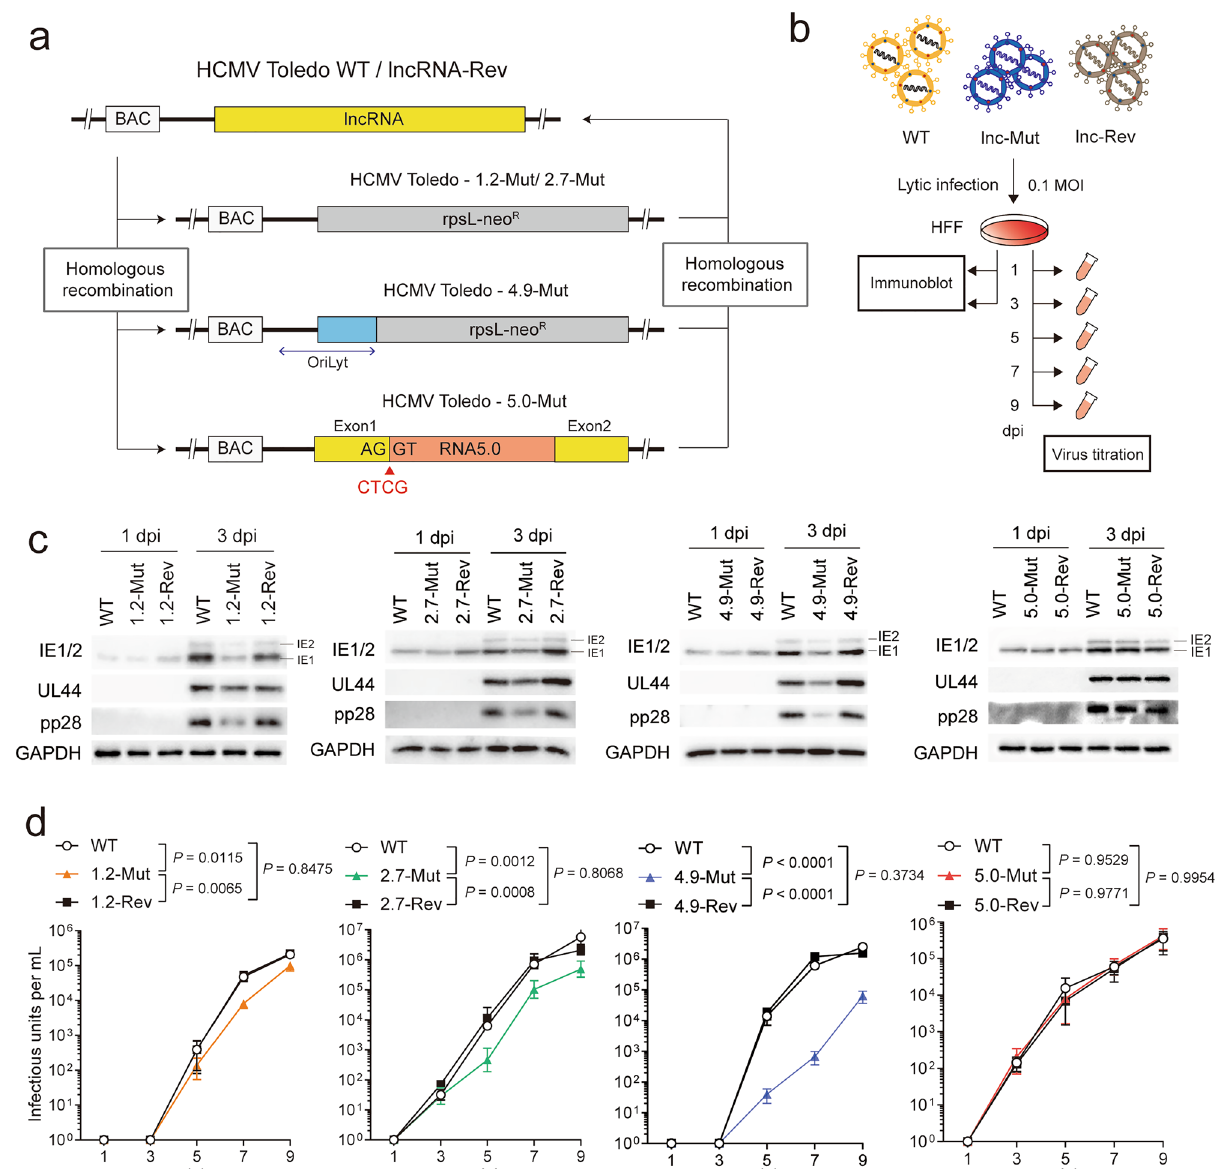
Figure 2. HCMV lncRNAs other than RNA5.0 are required for lytic replication in HFFs. ( a ) Schematic representation for generation of HCMV lncRNA-Mut virus. ( b ) Schematic representation of lytic infection analysis in HFFs using WT, lncRNA-Mut, and lncRNA-Rev viruses. ( c ) Immunoblot assay of viral proteins, which indicate the lytic replication phase (IE1/2, Immediate early; UL44, early; pp28, late). GAPDH served as a loading control. Images are representative of two independent experiments. ( d ) Cell-free viral particles from supernatant medium were titrated via limiting dilution assay. Data represents mean ± SEM, and the statistical significance was calculated by two-way ANOVA with Tukey’s multiple comparisons test (n =